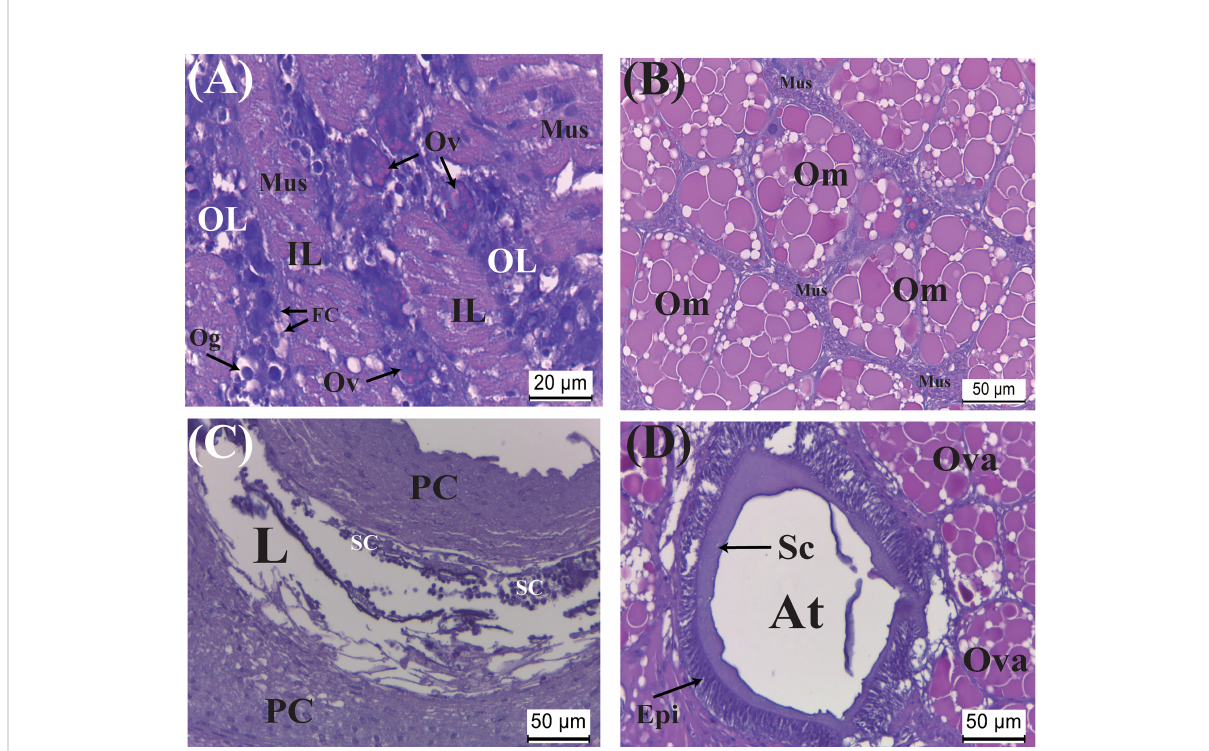
FIGURE 4 Developmental characteristics of the externa of Polyascus planus parasitizing the thukuhar shore-crab ( Metopograpsus thukuhar ) in the Orange stage. In this stage, (A) while the vitellogenic oocytes continue developing, an early event is an expansion of interlobular tissue with the muscles cell become larger and elongated. As the development continues toward the end of the stage, (B) ovarian maturation, (C) spermatogenesis inside the male receptacle, and (D) maturation of the colleteric gland are nearly completed. Om, mature oocyte; Sc, secretion; SC, spermatocyte. Other abbreviations are as indicated in Figures 2,